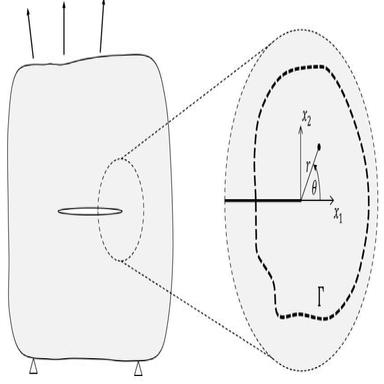
Local cartesian and polar coordinate systems at the crack tip. Integration path Γ surrounding the crack tip.